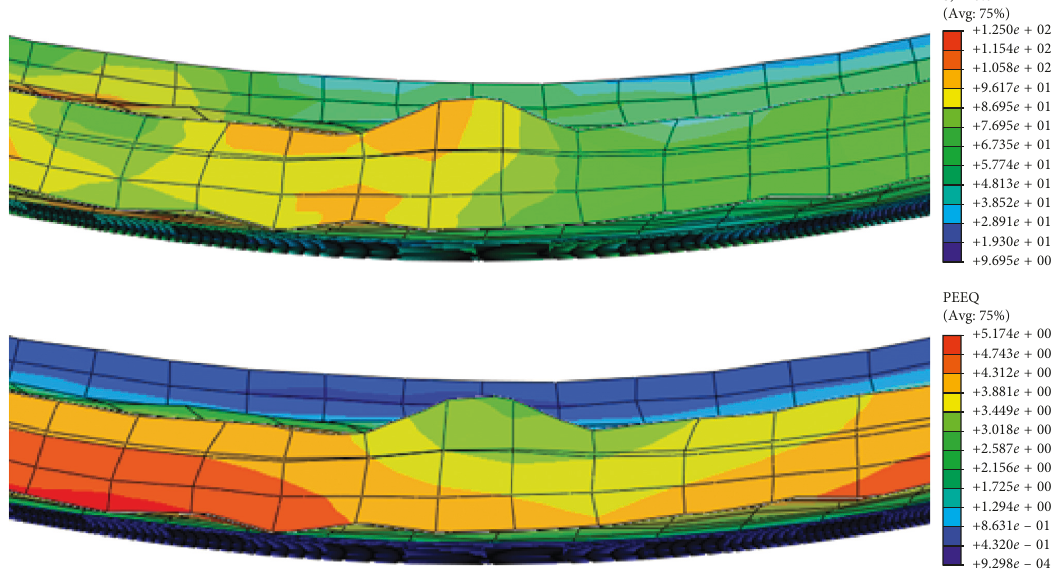
Figure 10: Mises stress diagram and equivalent strain diagram of the longitudinal ribs ( α � 20 ° , Ψ � 46%, and f � 150mm/min).